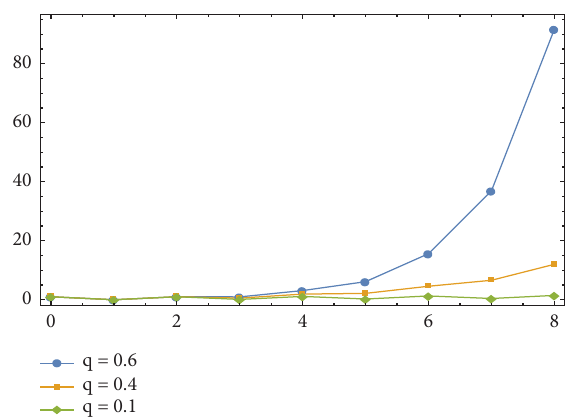
Figure 1: Locations of D